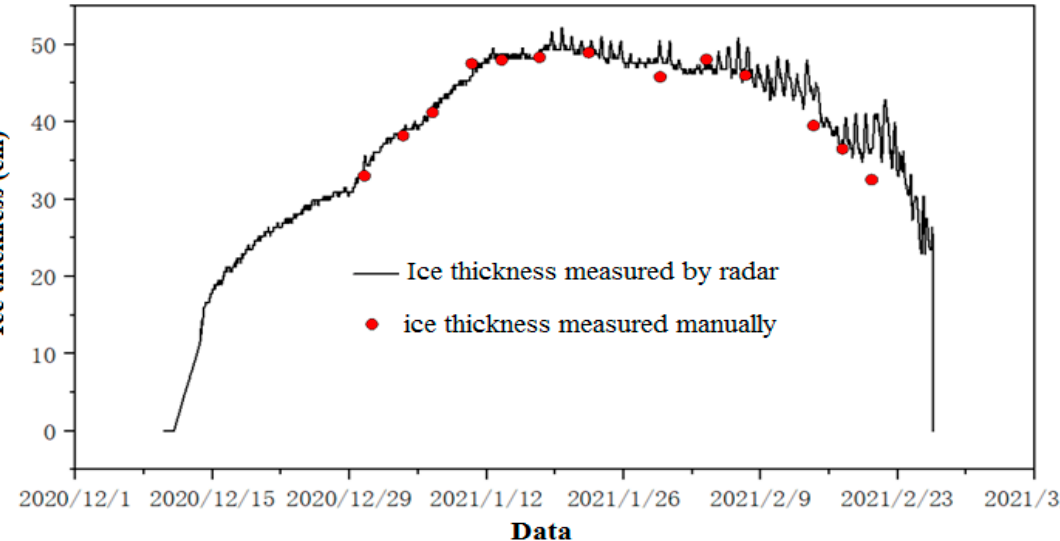
Figure 12. Comparison diagram of ice thickness results measured by radar and manual methods in the 2020–2021 ice period.